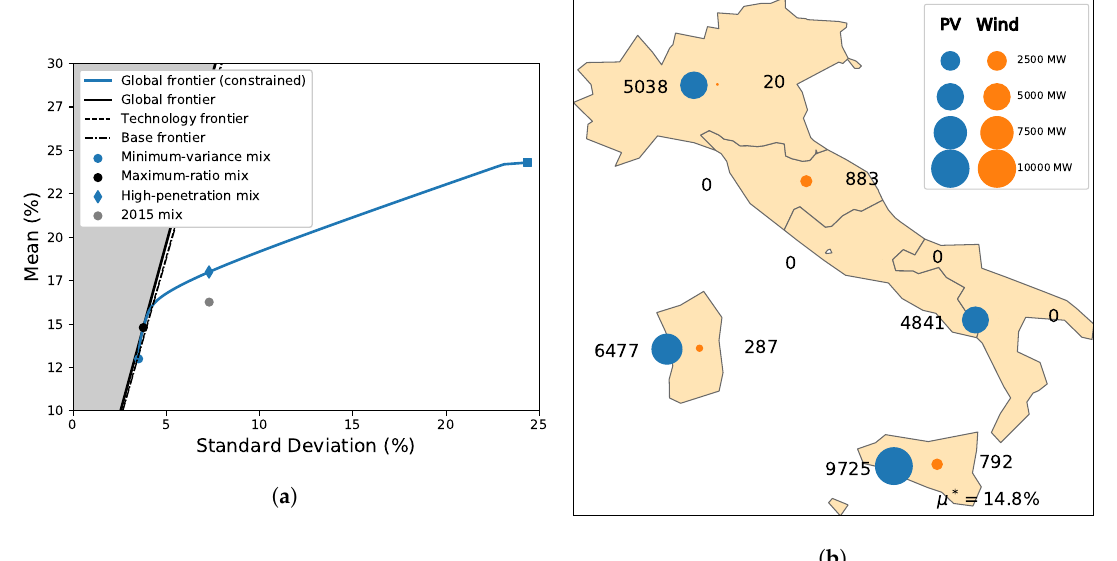
Figure 9. Optimal frontiers approximations ( a ) and PV-wind distribution for the maximum-ratio mix ( b ) computed using daily CORDEX data without the intraday parametrizations. To be compared with Figures 4a and